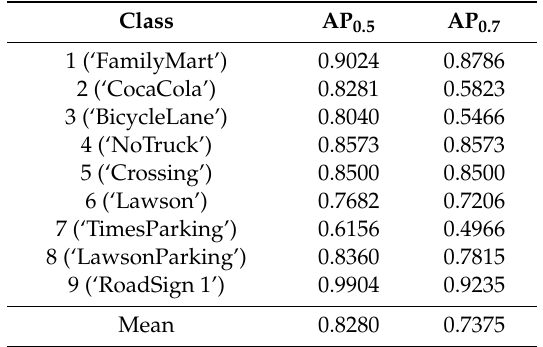
Table 1. Average precision values of detection results from Faster R-CNN, with 0.5 and 0.7 intersection over union